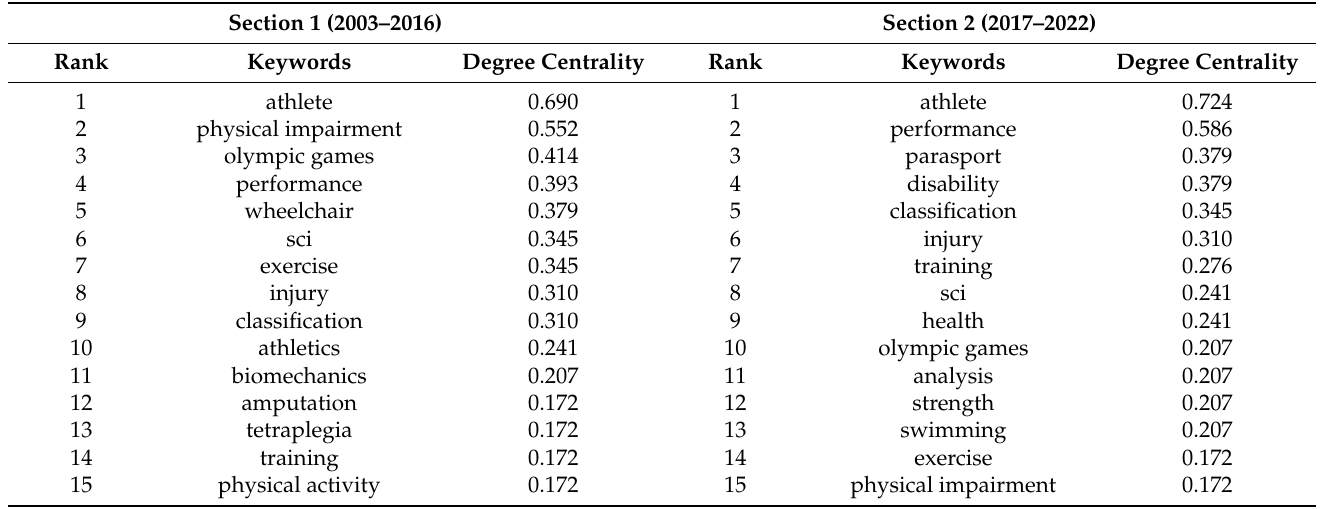
Table 2. DC of Top 15 keywords of Paralympic studies in Section 1 (2003–2016) and Section